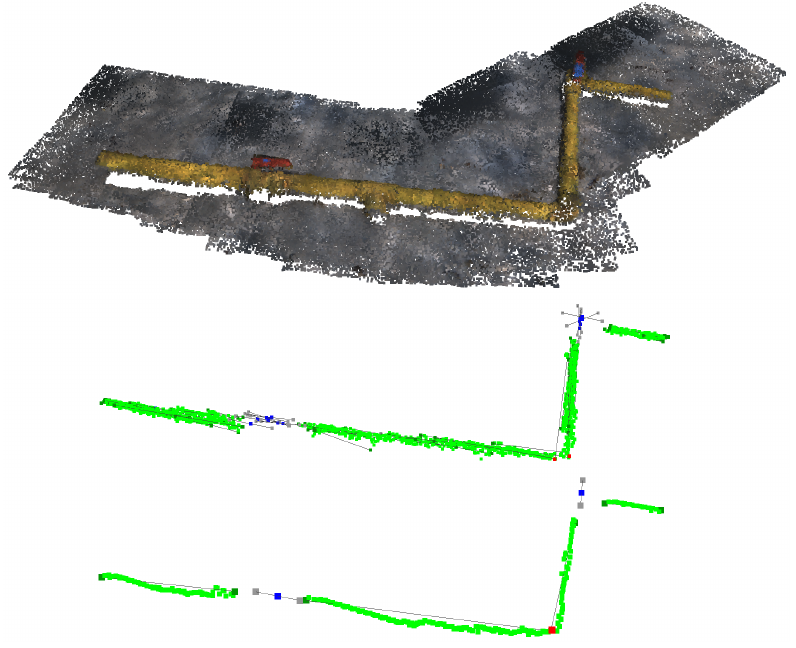
Figure 13. IUA implementation over T MAP test set. Top : Overlapped point clouds. Middle : Over- lapped extracted information from IEA. Bottom : Unified information from